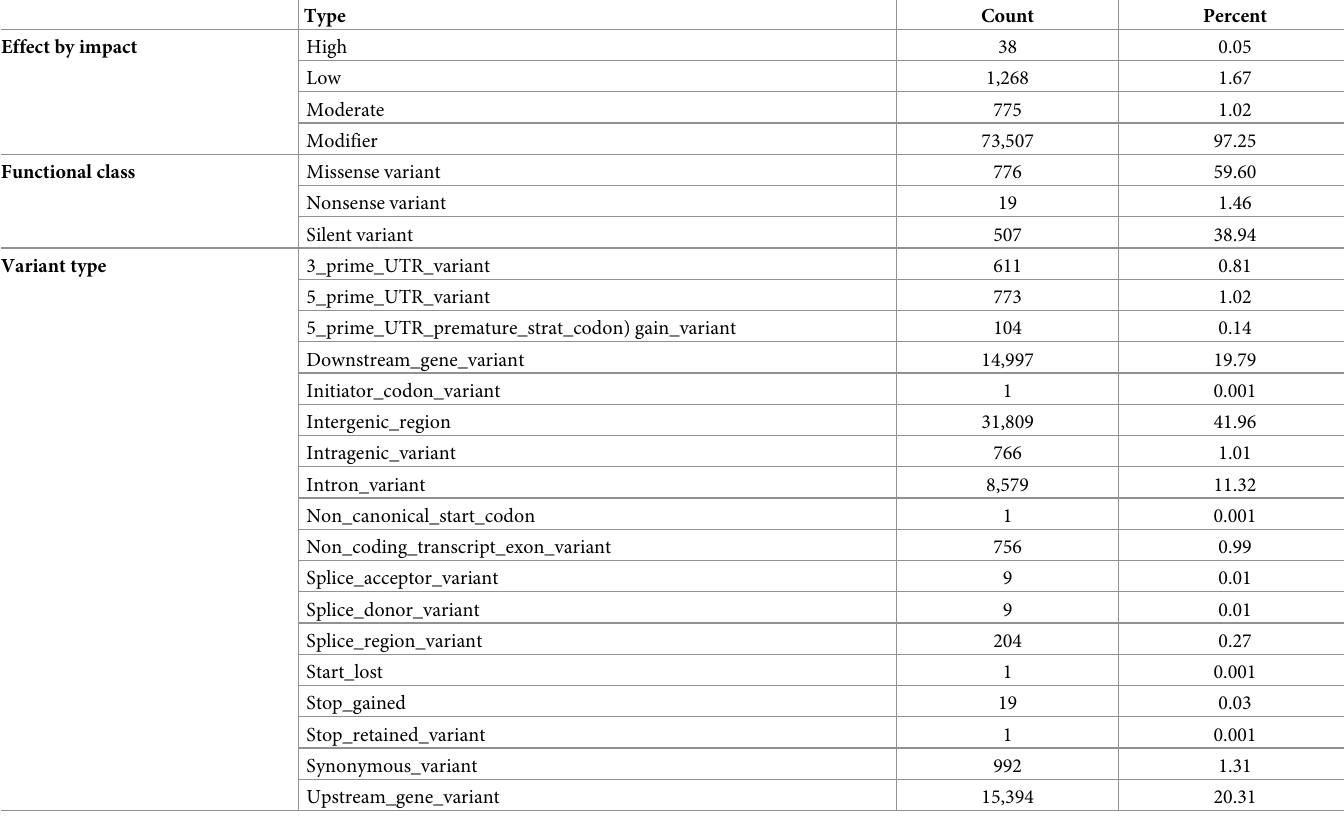
Table 1. SnpEff summary of variant effects by impact and functional class of GBS derived